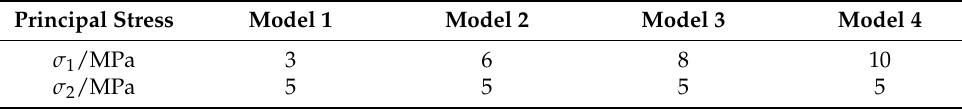
Table 2. Numerical model stress state setting